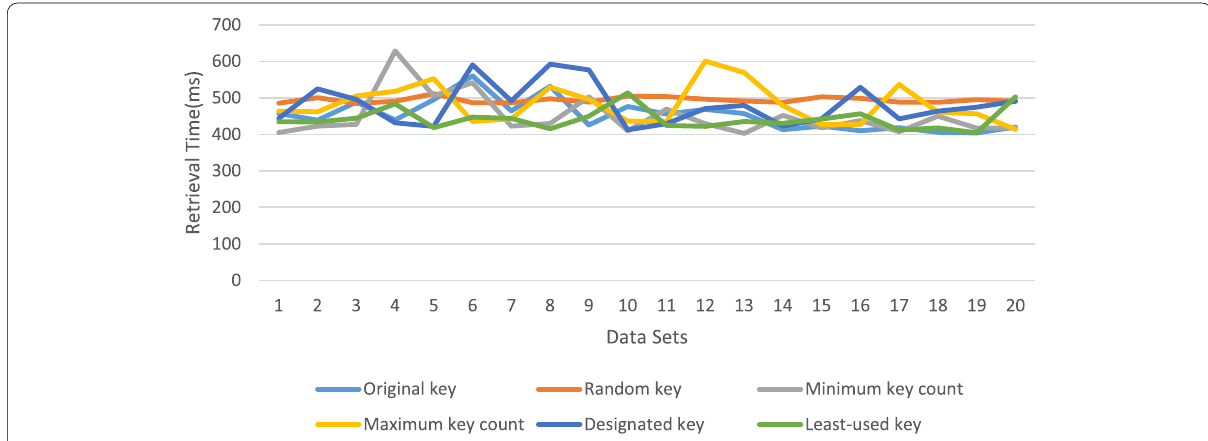
Fig. 15 Retrieval time on full index models generated using the six key selection methods with equal appearing probabilities of